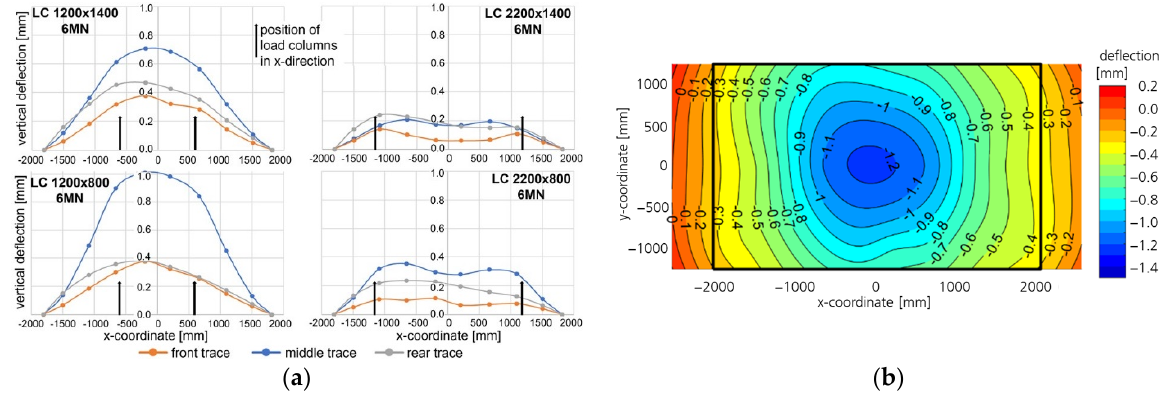
Figure 2. ( a ) Measured elastic deflection of the press table under four different load scenarios (summed load of 6 MN, 75% nominal press load) with three traces each (front, middle, and rear); ( b ) derived compliance of press table (load of 6 MN at 1200 × 800 mm load column position).